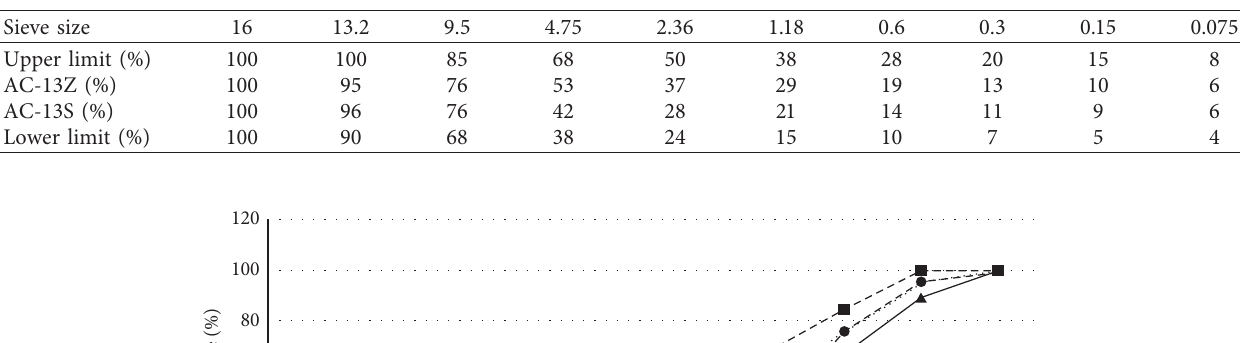
Table 4: Gradations.